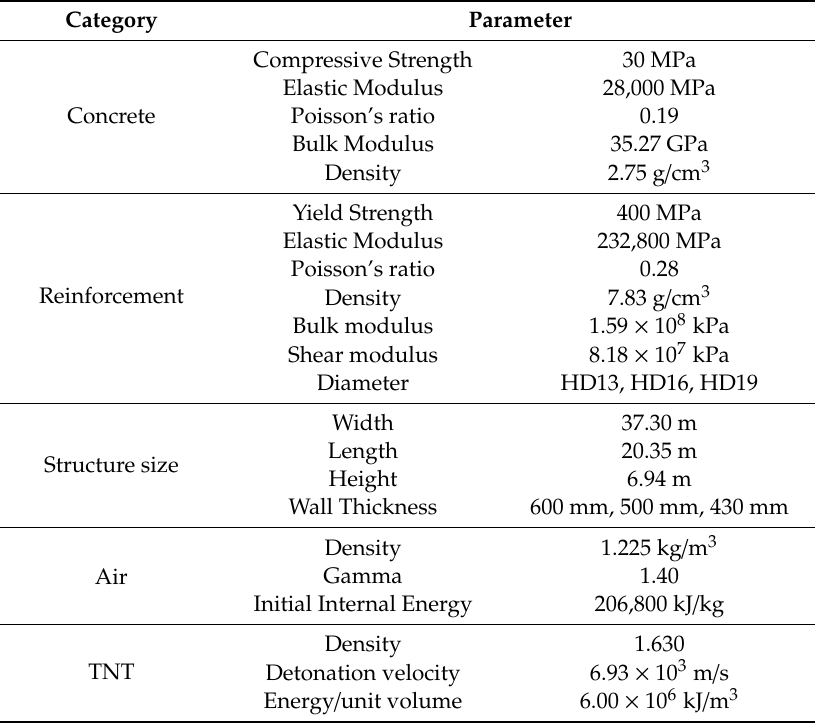
Table 2. Material properties used in FE